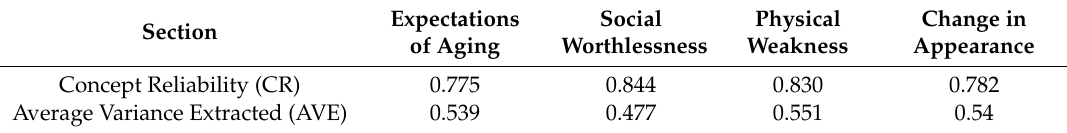
Table 5. AVE and CR for aging